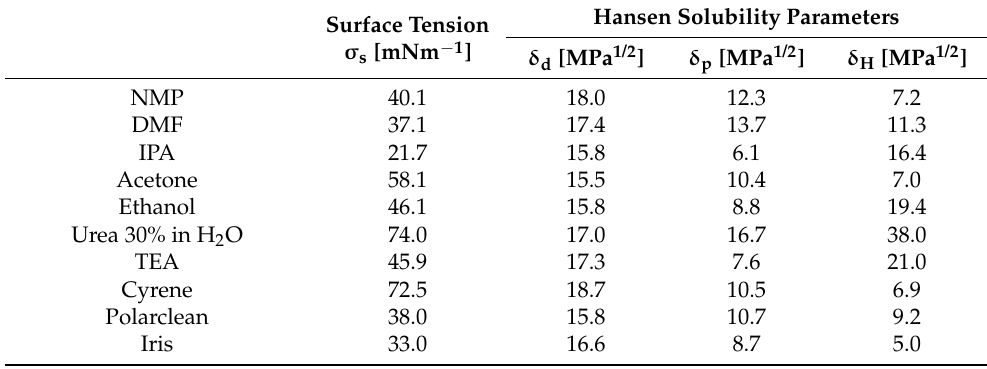
Table 1. Surface tension and the Hansen solubility parameters for NMP, DMF, IPA, Cyrene, Polarclean, and Iris.